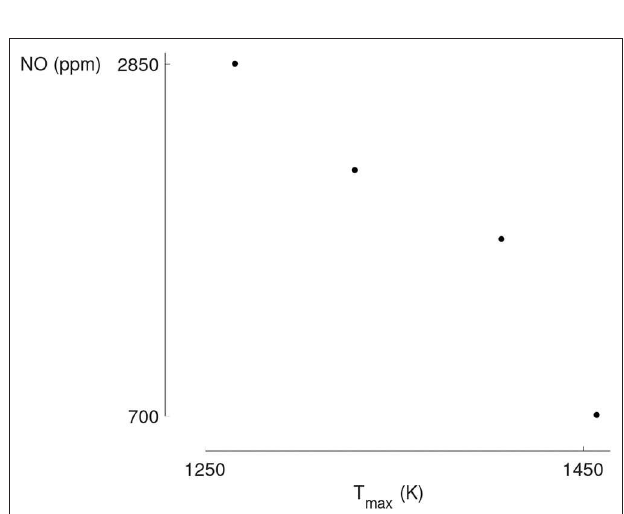
FIGURE 19 | For a maintained ammonia and hydrogen intake flow rate of 6 nlpm and decreasing intake temperature (set #6), the NO emissions start to soar when the maximal combustion temperature decreases below 1,400 K. The UV spectrometer is suspected to be flawed by N 2 O, whose absorbtion spectrum is similar to that of NO.